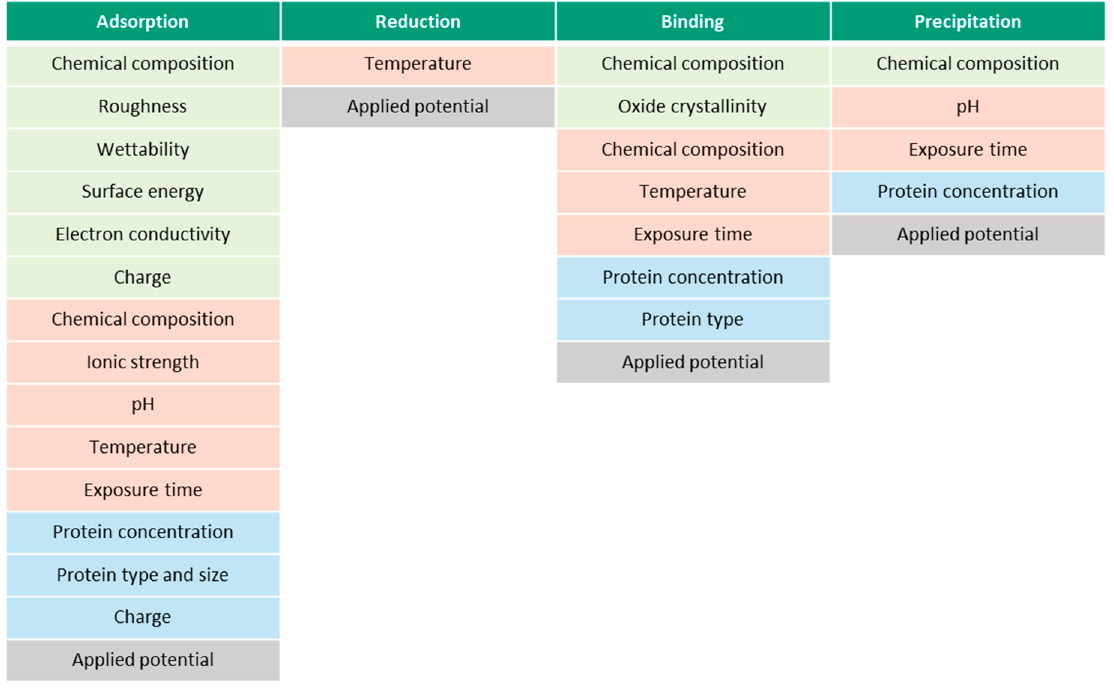
Figure 9. E ff ect of various parameters (material- (green), solution- (red) and protein-related (blue)) on protein-related